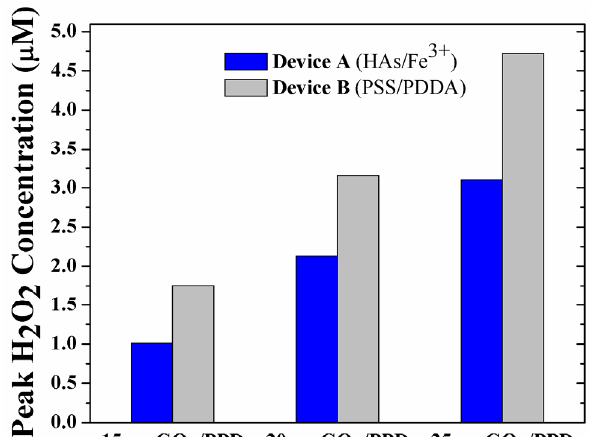
Figure 6. Peak H of enzyme thickness (15, 20 and 25